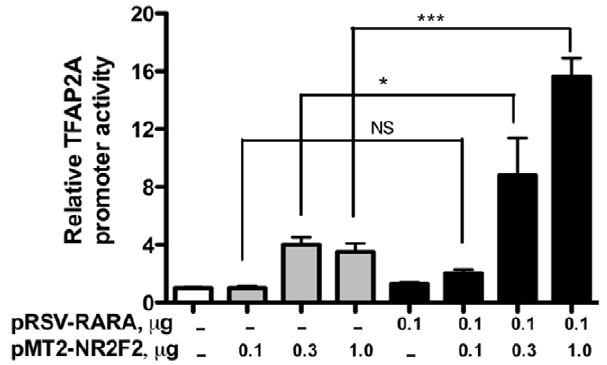
Figure 6. The effect of RARA on NR2F2-induced TFAP2A promoter activity. JEG-3 cells were co-transfected with pGL3 b - TFAP2A-Luc and pMT2-NR2F2 in the presence and absence of pRSV- RARA. An equivalent amount of the empty pRSV plasmid was co- transfected into the cells that were not co-transfected with pRSV-RARA. Each bar represents the mean of triplicate wells; and the brackets enclose 1 SEM. NS=not significant; *=p , 0.05; ***=p , 0.001. Similar results were obtained in two other experiments.